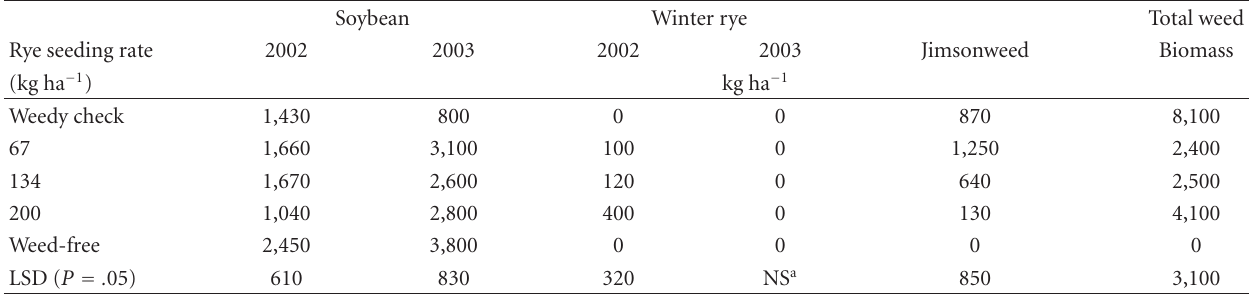
Table 2: E ff ect of winter rye seeding rate on soybean, winter rye, jimsonweed, and total weed fresh weight biomass at physiological maturity in 2002 and 2003. Data were combined over years and row spacings unless denoted